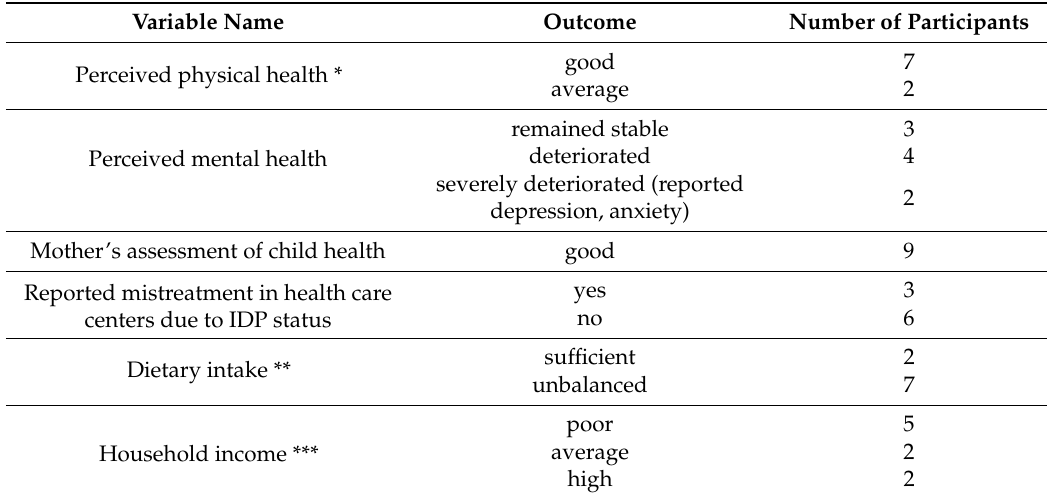
Table 2. Summary of self-reported health and well-being